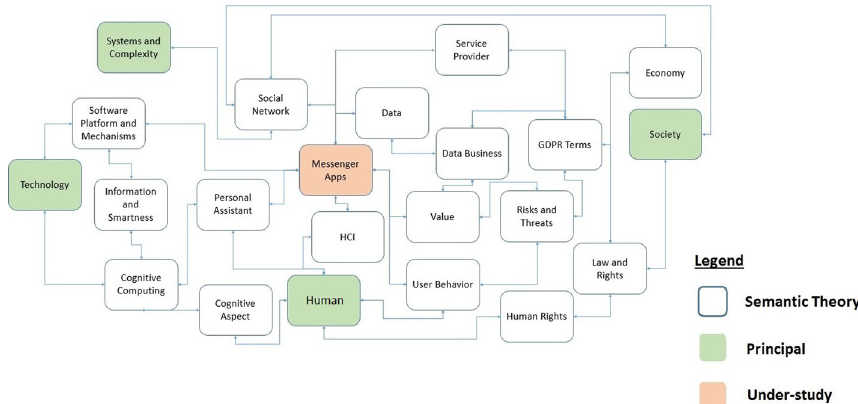
Fig. 7 A detailed map of involving semantic theories in the IR-QUMA